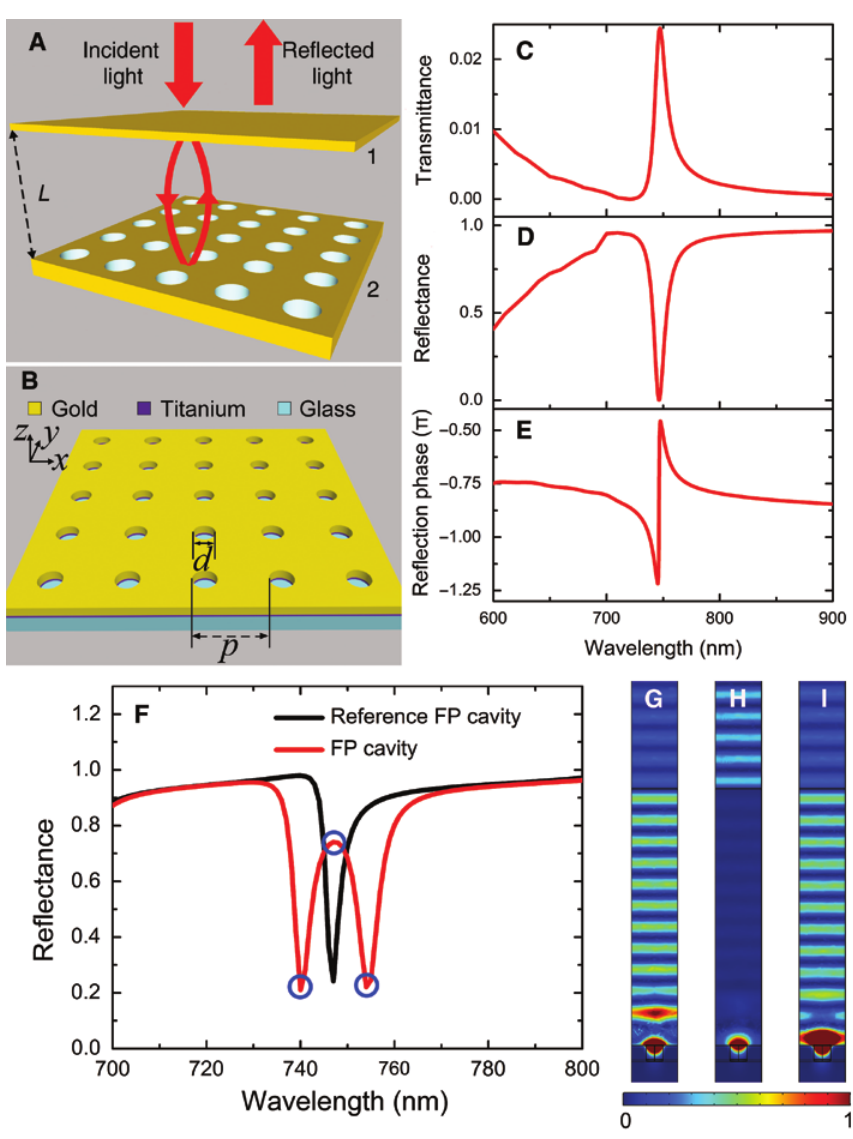
Figure 1: (A) Schematic and geometric parameters of the FP cavity. (B) Schematic and geometric parameters of the nanohole array in the gold film. Simulation results of the (C) transmission spectrum, (D) reflection spectrum, and (E) reflection phase of the nanohole array normally illuminated by the p-polarized incident light. (F) Simulated reflection spectra of the proposed FP cavity and the reference FP cavity when the cavity length is L = 4415 nm. Simulated field distributions (| E | 2 ) of the proposed FP cavity at (G) λ = 740 nm, (H) λ = 747 nm, and